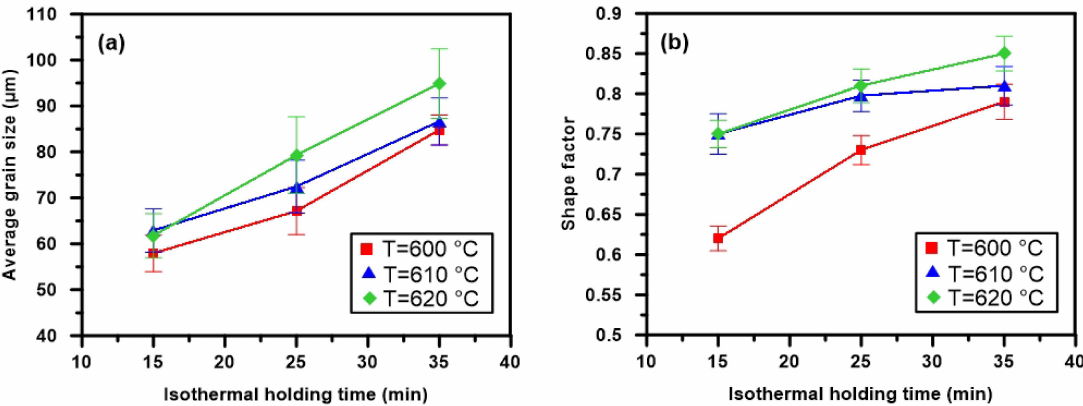
Figure 12. Variations of ( a ) the average grain size; ( b ) shape factor versus isothermal holding time of compressed samples heated at 600, 610, and 620 ˝